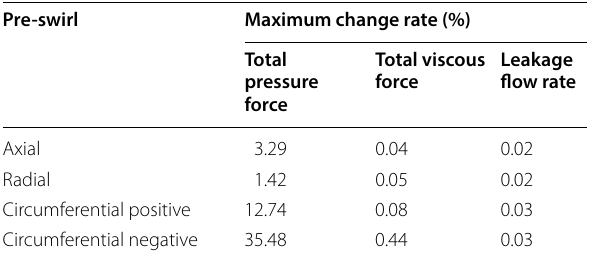
Table 6 Maximum change rate of the four types of pre- swirls